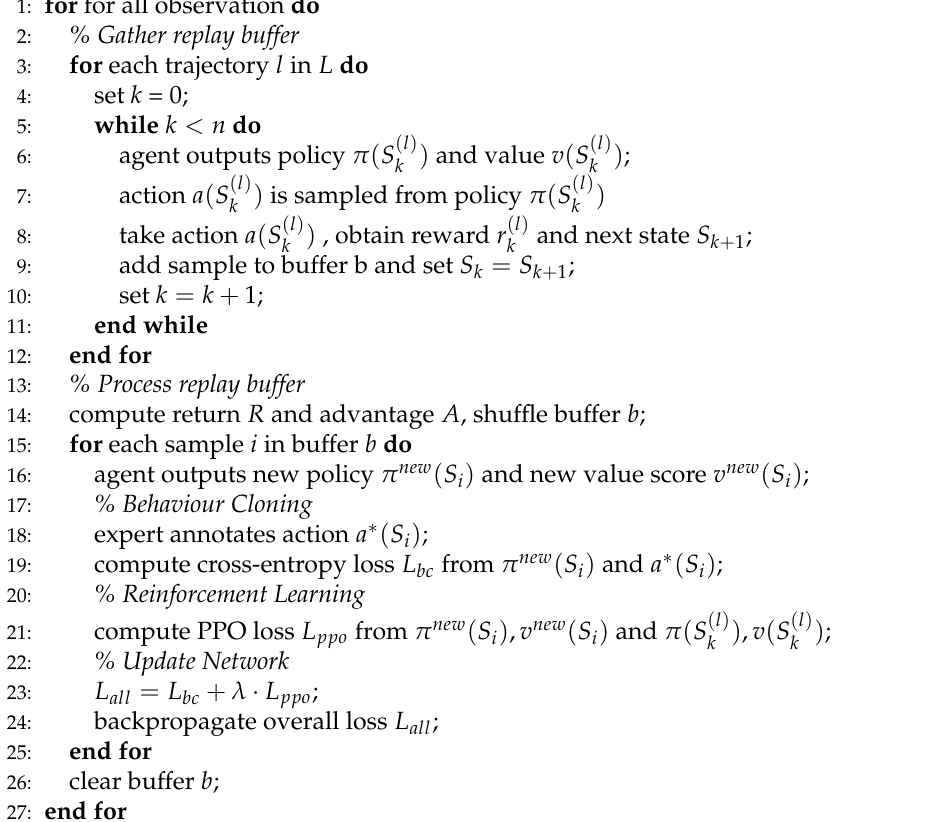
Algorithm 1 The Joint Behaviour Cloning and Reinforcement Learning using a Re- play